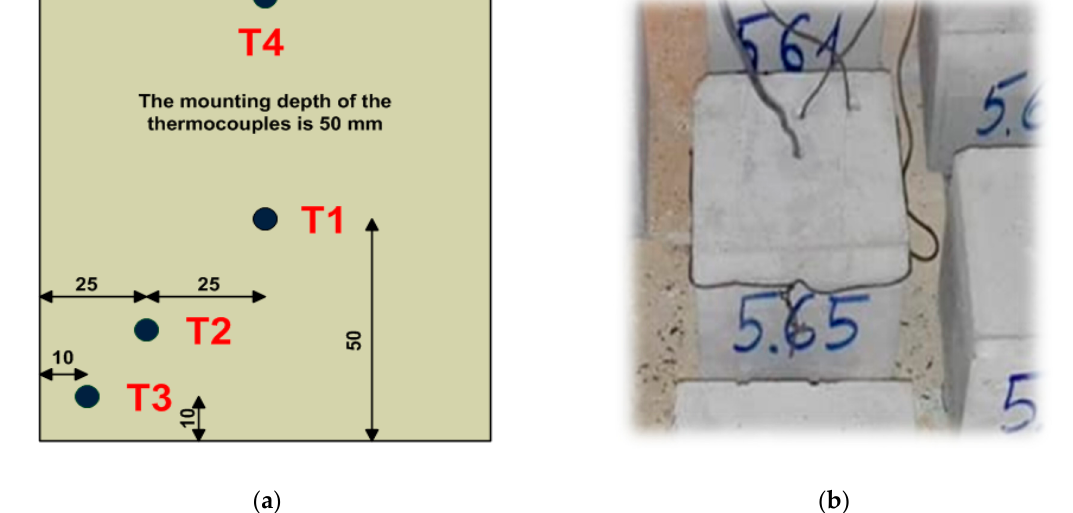
Figure 2. Cubic sample: ( a ) arrangement diagram for thermocouples in the sample; ( b ) view of the sample with measuring thermocouples attached.